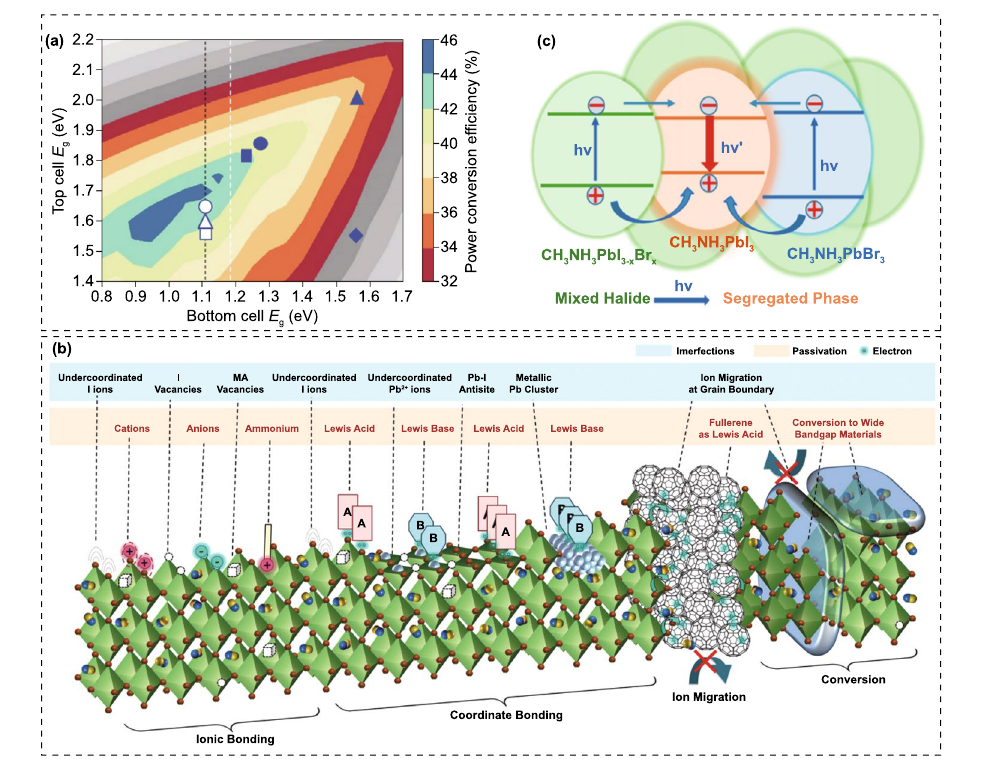
Fig. 3 a Theoretical efficiency limit for 2-T tandems. Reproduced with permission from Ref. [55]. Copyright 2018, Nature Publishing Group. b Defects (imperfections) in perovskite film and their passivation strategies. Reproduced with permission from Ref. [61]. Copyright 2019, Royal Society of Chemistry. c Phase segregation and corresponding charge transfer behavior. Reproduced with permission from Ref. [62]. Copyright 2016, American Chemical